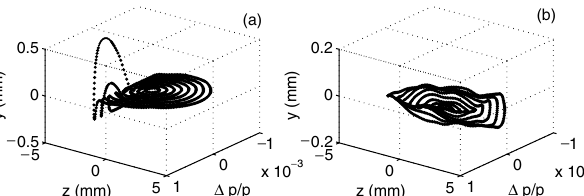
FIG. 36. (Color) Horizontal and vertical beam size increase along a PEP-II bunch train with 8.5 ns bunch spacing, simulated by a microbunch model [40]; the electron density was assumed to reach an asymptotic value of 2 (cid:1) 10 11 m (cid:2) 3 with an exponen- tial saturation time of 50 ns; the final density is a factor 2.5 below the TMCI